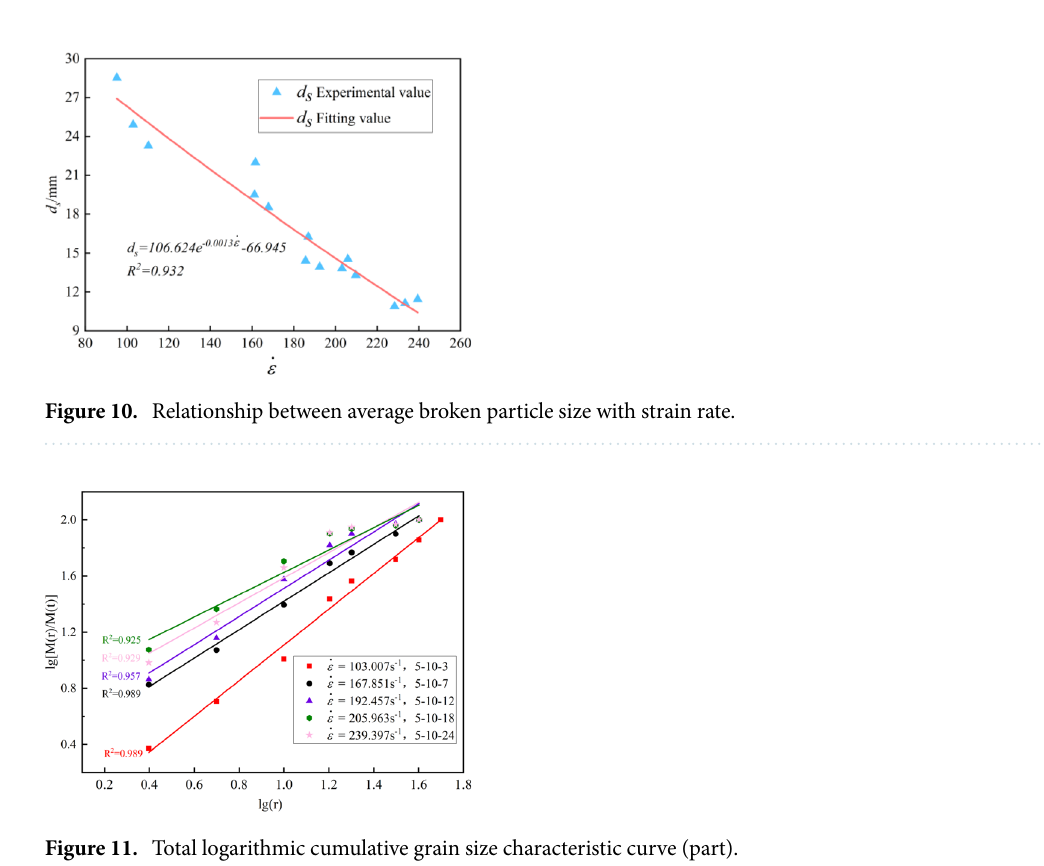
Figure 9. Cumulative percentage of fragments of different sizes.